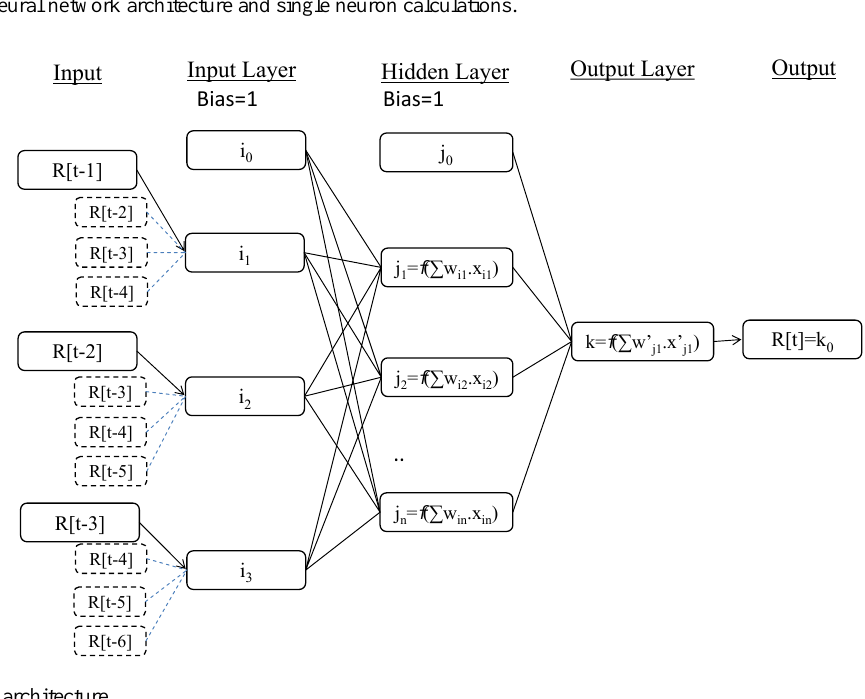
Figure 4 Input Delay Neural Network Architecture and Single Neuron Calculations Fig. 4. Input delay neural network architecture and single neuron calculations.